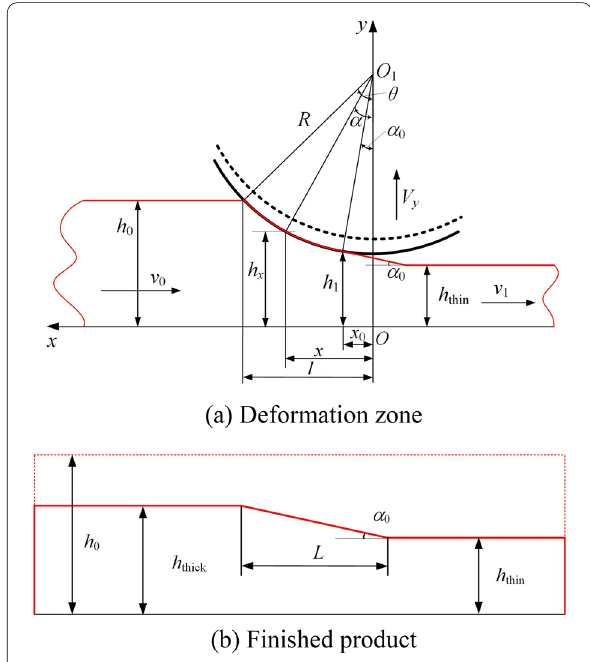
Figure 2 Schematic diagram of the deformation zone and finished product in upward rolling